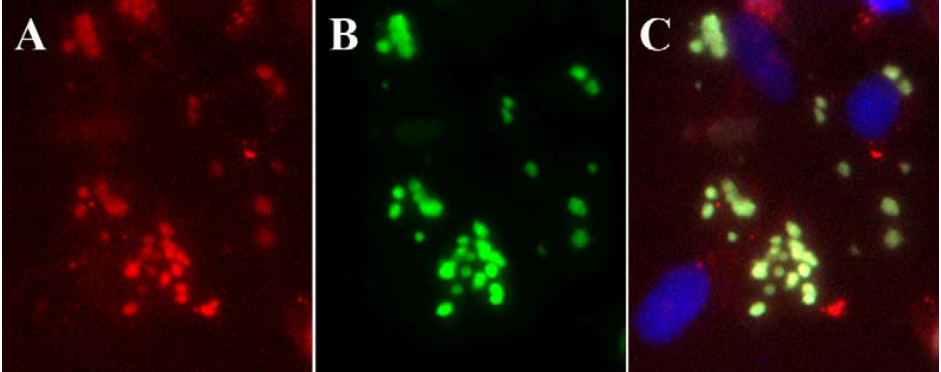
Figure 4. 4'-thioIDU is incorporated in virus factories. (A) Cells infected with vaccinia virus were labeled with a monoclonal antibody (red staining); (B) 4'-thioIDU incorporated in viral DNA was visualized with a monoclonal antibody and localized to virus factories (green staining); (C) a merged image shown with nuclei labeled with DAPI show that most of the compound appears to be incorporated in viral DNA rather than in host DNA in the